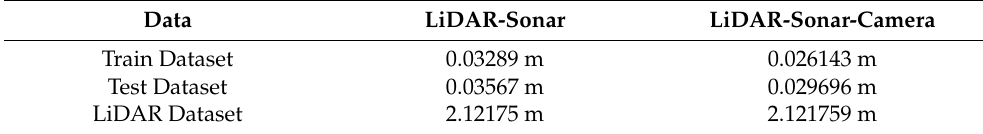
Table 7. RMSE between fusion strategies and LiDAR vs. Ground